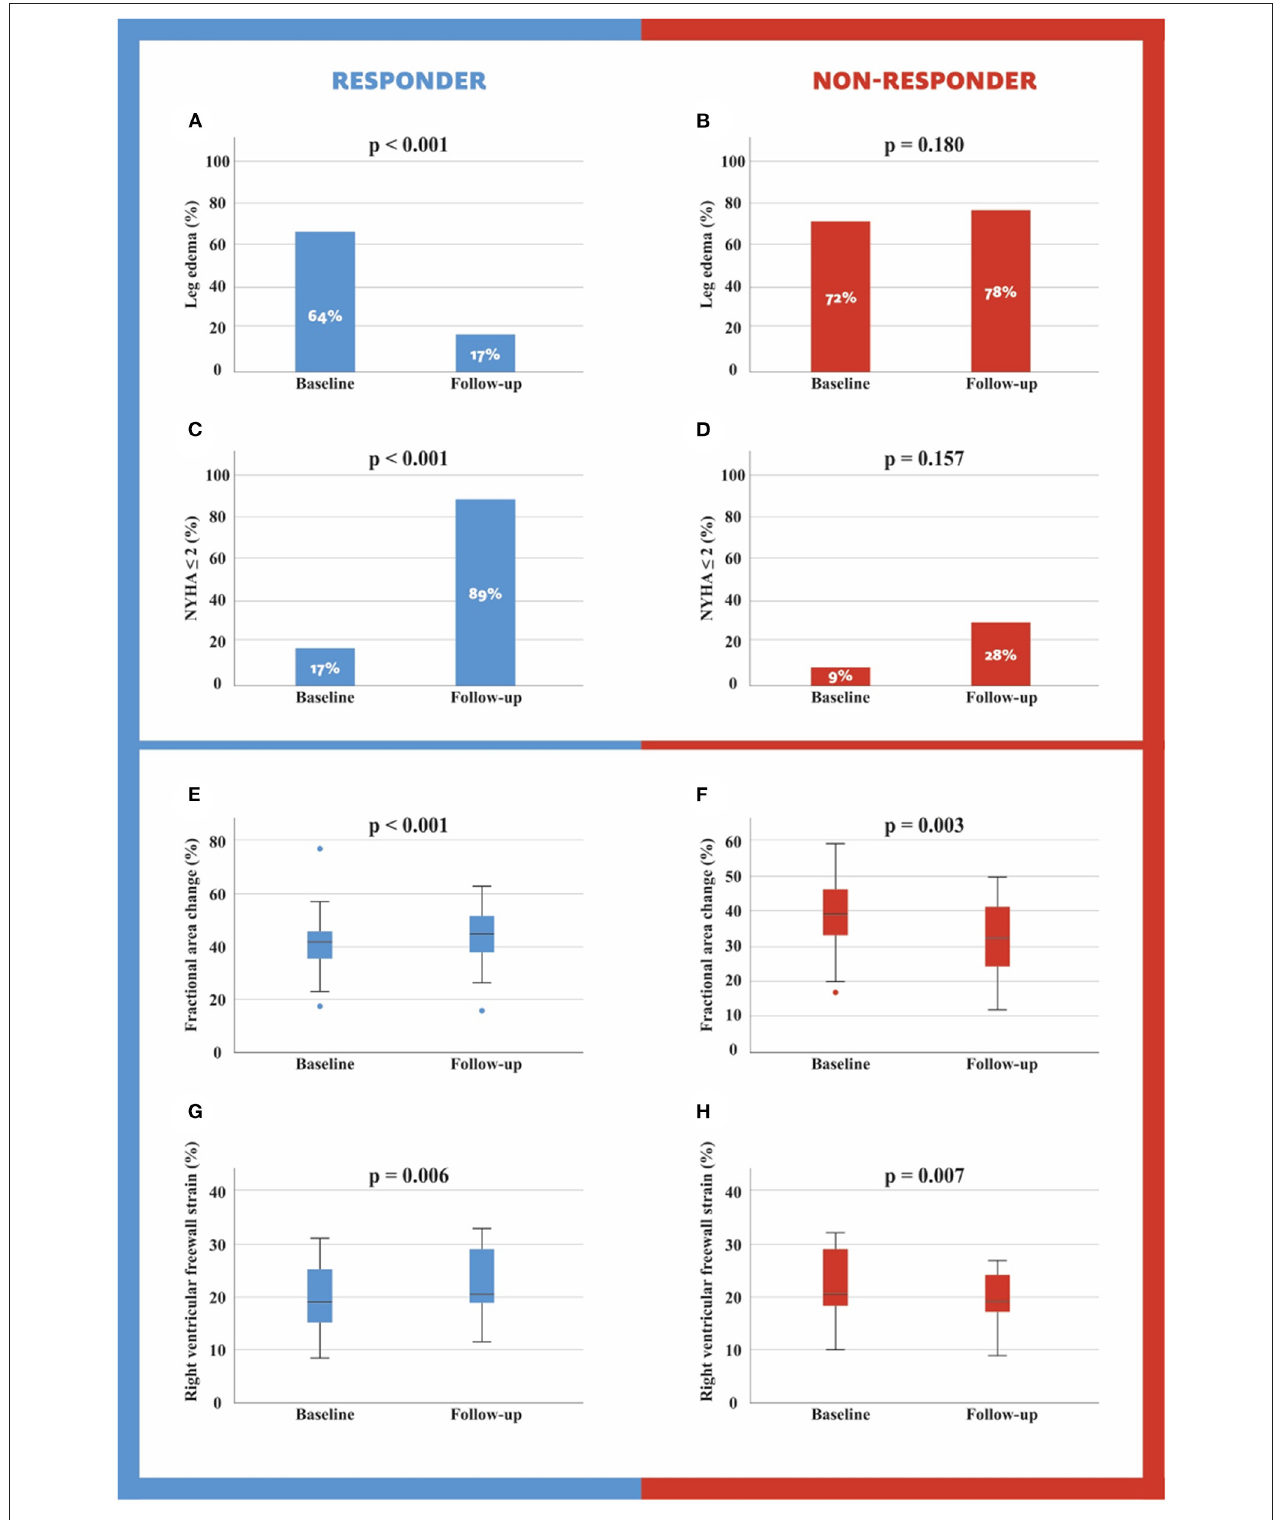
FIGURE 2 | Leg edema and NYHA score at baseline and follow-up for responders and non-responders (A–C) . Fractional area change and right ventricular freewall strain at baseline and follow-up for responders and non-responders (D–H) .